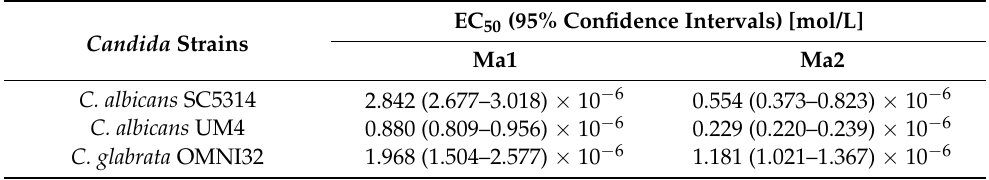
Table 2. In vitro activity of Ma1 and Ma2 against early-stage Candida biofilm.